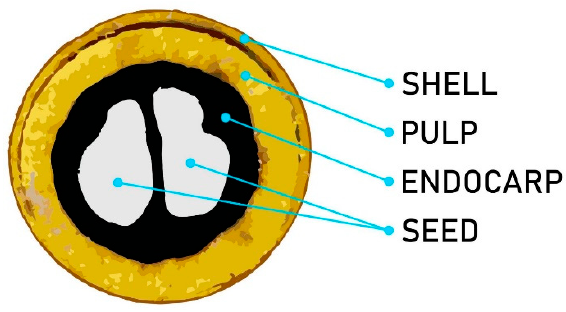
Figure 1. Illustration of Acrocomia aculeata (Jacq.) Lodd fruit and its parts.